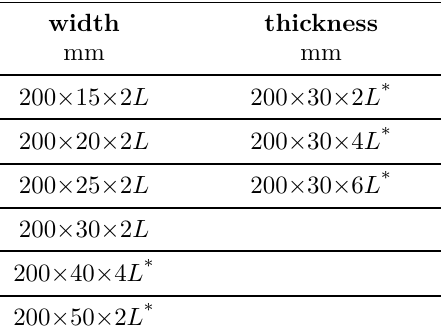
Table 1. Tensile test study: varying specimen di- mensions; L =Layers; * tests performed on Zwick/Roell Z150